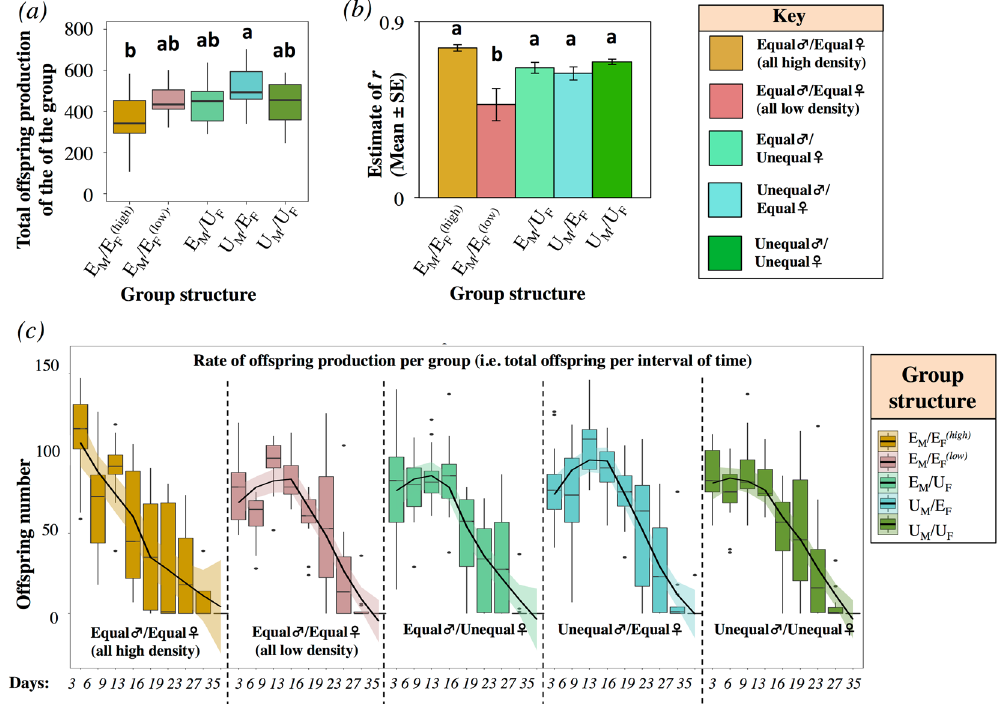
Figure 3. Estimates of group reproductive success, fitness, and offspring production rate. ( a ) Total lifetime offspring production. ( b ) Age-specific fitness of groups ( r ). ( c ) Offspring production per interval of time. Post- hoc SNK test ( α =